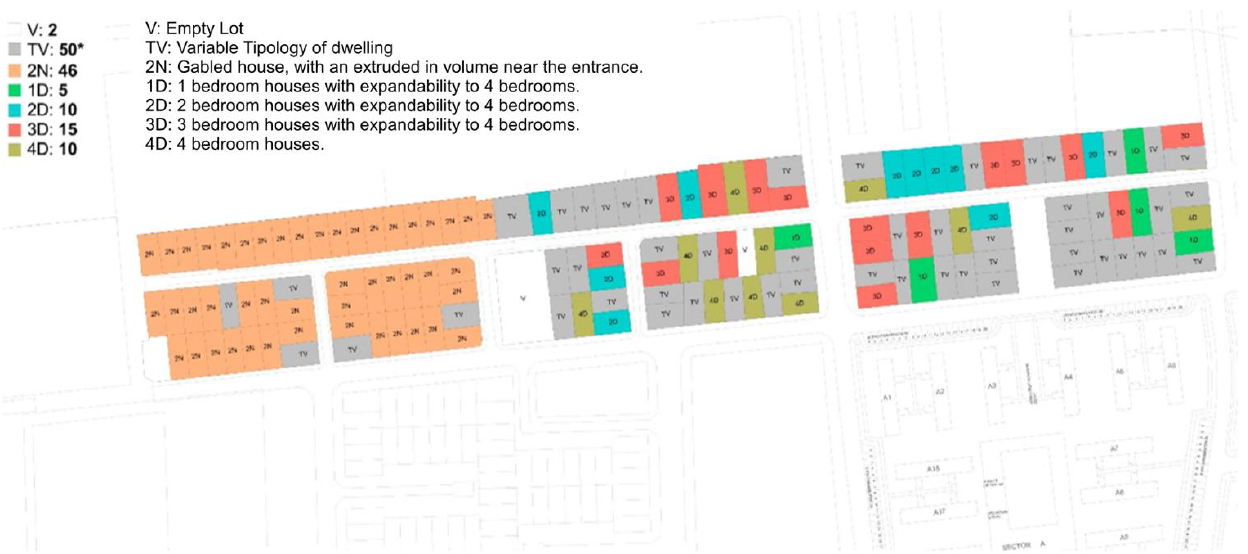
Figure A8. Dwellings urbandistribution by typology —part 2 (authors’ own preparation).